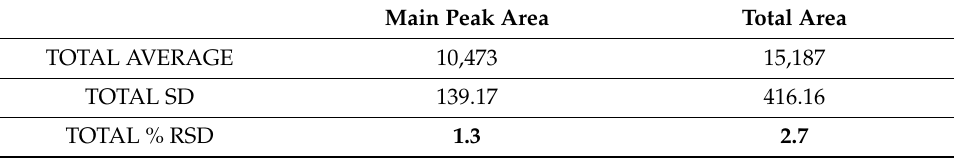
Table 6. Intermediate precision data compilation based on set 1 and set 2 repeatability